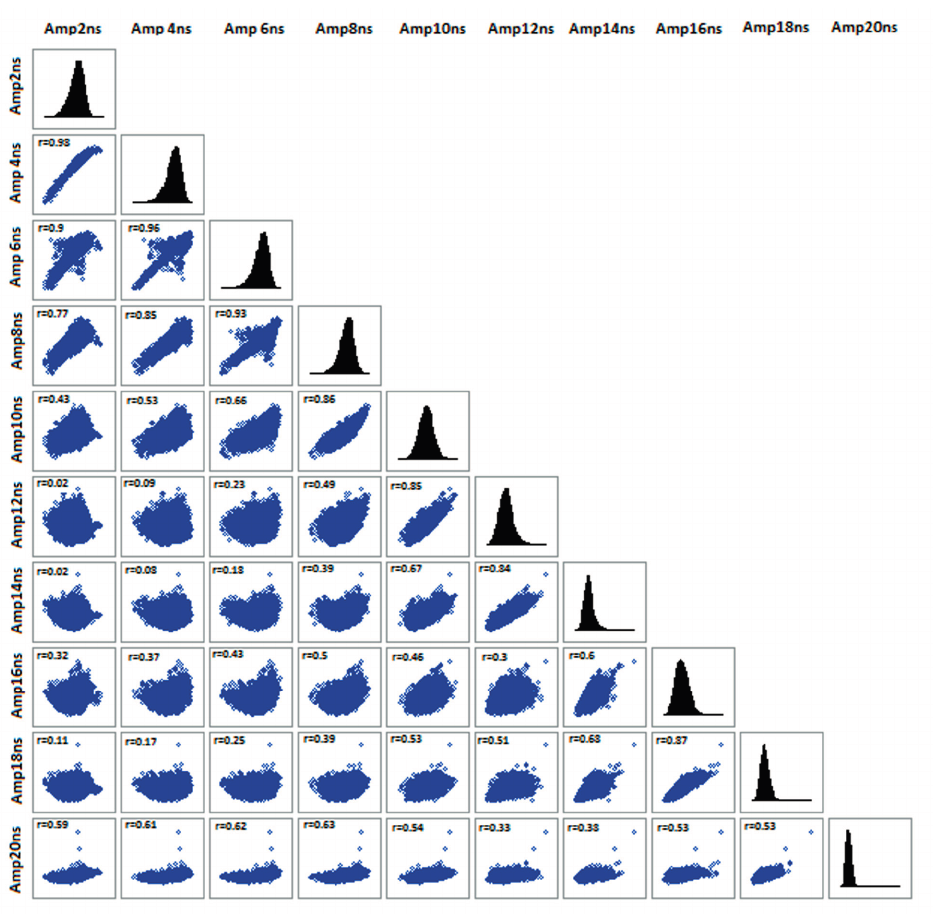
Figure 5. Graph of correlation matrix for GPR data acquired with 250 MHz antenna and processed with third processing procedure (time zero correction, dewow filter, bandpass filter and envelope). Person’s correlations (r) are reported and all coefficients are significant at 0.05 probability